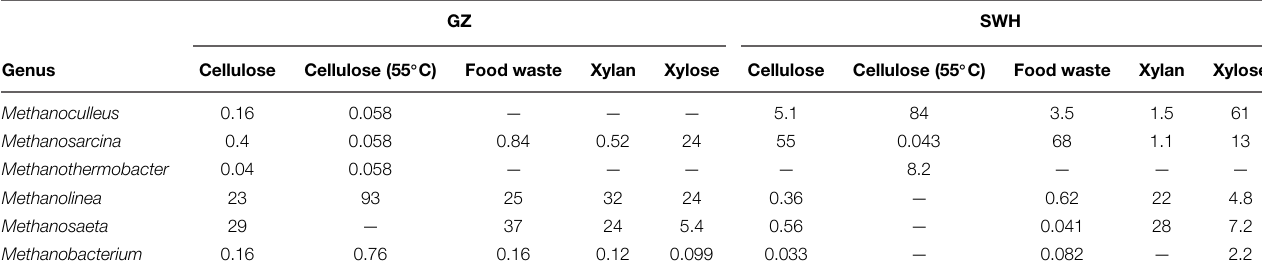
TABLE 2 | Relative abundances of the most abundant archaeal genera detected in this study.